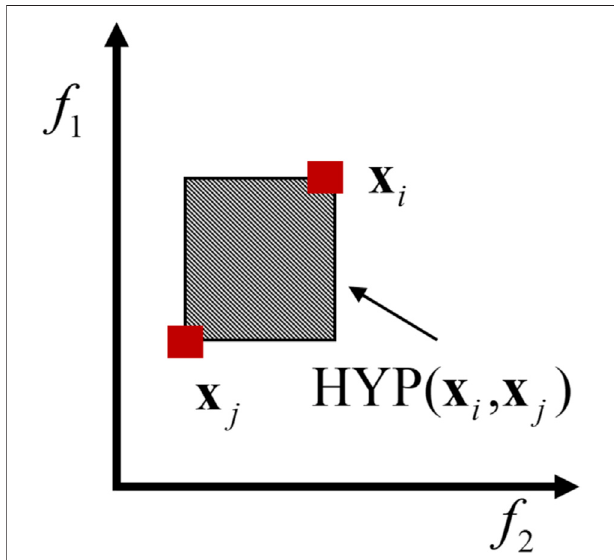
FIGURE 1 | Illustration of hypervolume in the bi-optimization